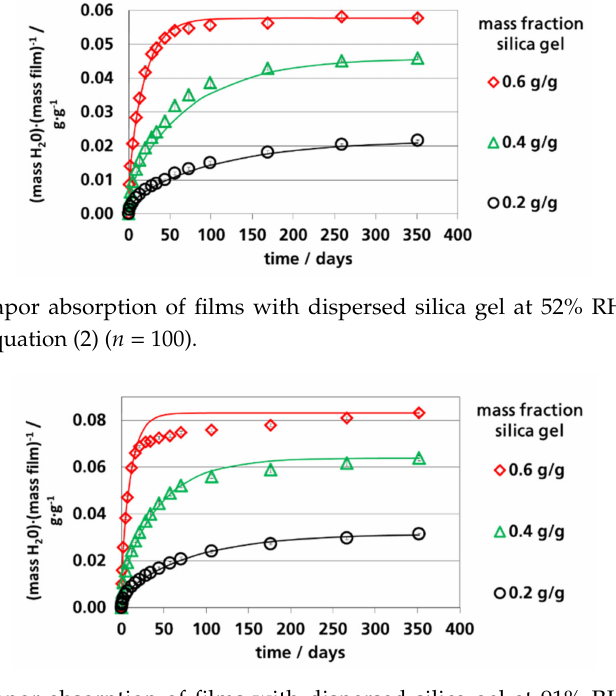
Figure 8. Water vapor absorption of films with dispersed silica gel at 91% RH and 23 ◦ C, lines: Calculated using Equation (2) ( n =